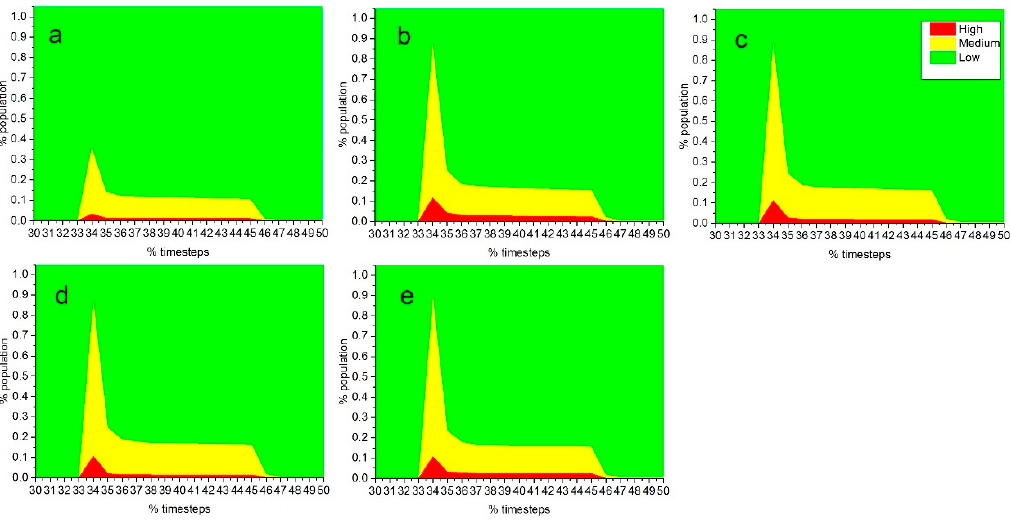
Figure 11. Risk reduction comparison. ( a ) Simultaneous, ( b ) proximity to the hazard (PH) prioritized, ( c ) population density (PD) prioritized, ( d ) accessibility to shelter (AS) prioritized, ( e ) vulnerable age (VA) prioritised scenarios (the data is provided in Supplementary Material S9).